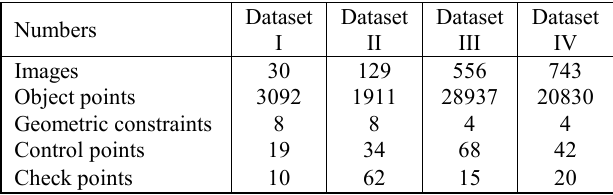
Table 1. Specifications of four Dunhuang wall painting datasets Both improved CGBA and GEBA are programmed in Visual C++. The basic runtime environment include: